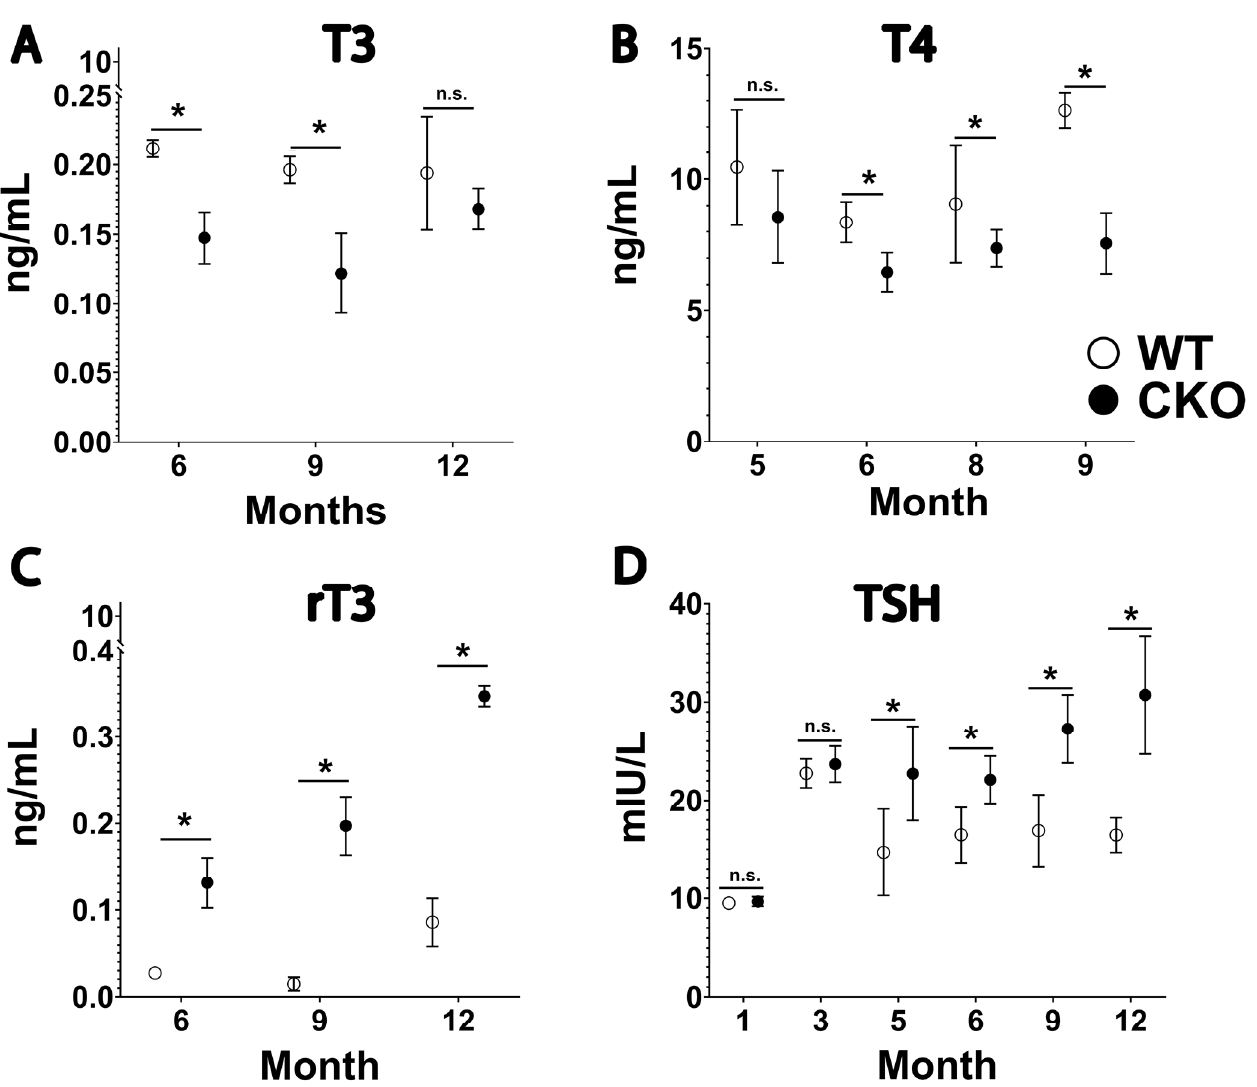
Figure 2. Plasma thyroid hormones and thyroid-stimulating hormone levels of CKO and W.T.